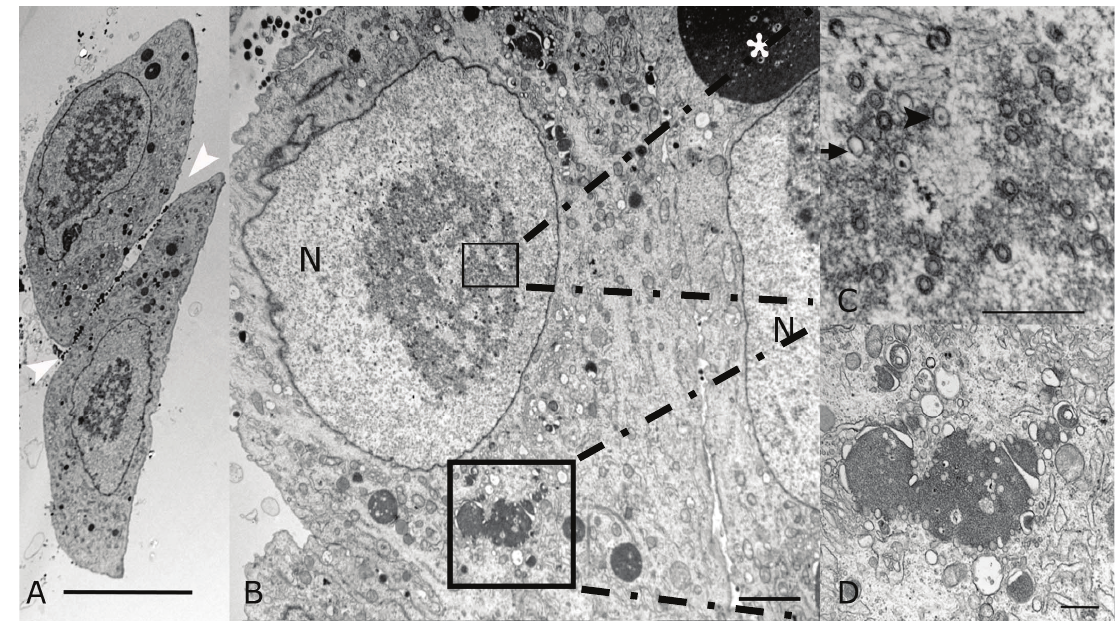
Figure 2. Transmission electron microscopy (EM) microphotographs of fibroblasts infected with the CIDMTR Strain of GPCMV. ( A ) Plastic embedded preparation contrasted with uranyl acetate/lead citrate of two enlarged fibroblasts showing cell intranuclear and cytoplasmic viral inclusions and numerous dense bodies (white arrowheads) in the intercellular space (bar = 10 µm). ( B ) Magnification of another CIDMTR-infected cell revealed nuclear (N) viral replication and nucleocapsid assembly sites (small square), as well as a large maturation site (asterisk) and dense body formation in the cytoplasm (large square, bar = 2 µm). ( C ) Additional magnification in which replication and capsid assembly in the nucleus (small square) is appreciated; note empty capsids (arrow) and DNA containing nucleocapsids (arrowhead; bar = 0.5 µm). ( D ) Magnification of virus maturation sites within the cytoplasm (large square in panel ( B )) reveals electron dense material formed by aggregation of nucleocapsids and cell organelles such as Golgi systems, endoplasmic reticulum and vesicles (bar = 0.5 µm). ( E ) Capsid is demonstrated becoming coated with tegument proteins and then acquiring its final envelope by budding into vesicles (arrows; bar = 0.5 µm). ( F ) Several dense bodies are present in the intercellular space (bar = 0.5 µm). ( G ) Negative contrast preparation of enveloped B-capsid (arrow) and dense body (asterisk, bar = 0.5 µm) is demonstrated. ( H ) EM of strain 22122-infected cells demonstrating virtually identical morphology; A, B and C capsids are identified as described in